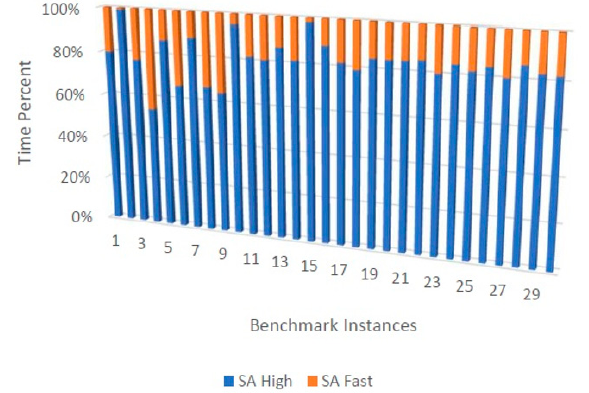
Figure 8. Contrast in the resolution time of the two SA schemes.